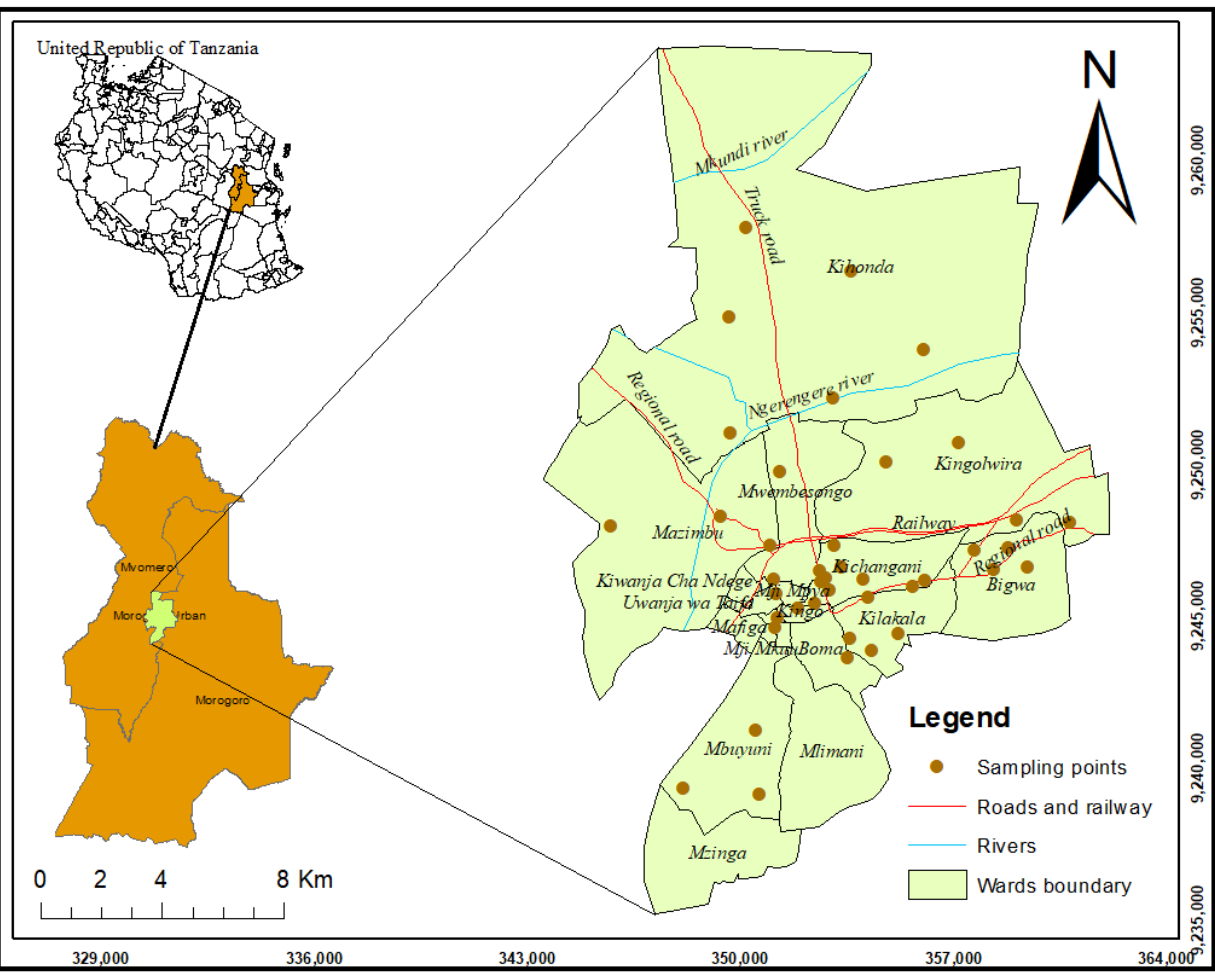
Figure 1. Location of the study area.